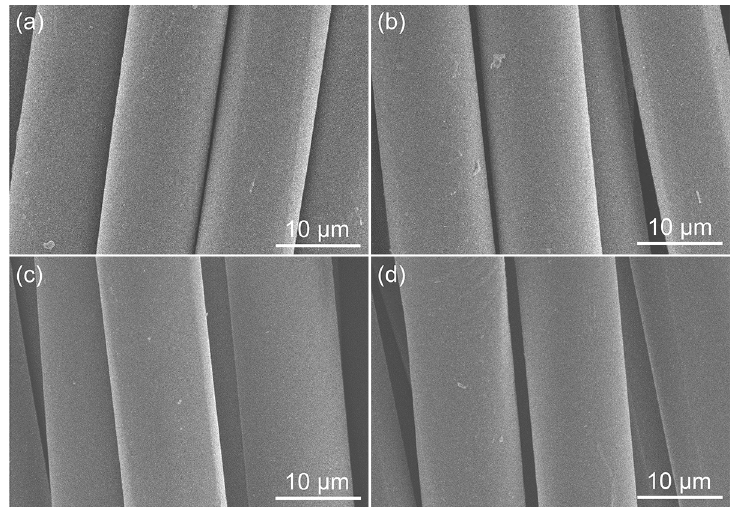
Figure 3. SEM images of PI fibers ( a ) and the PI fibers treated with N-methylformanilide (MFA) ( b ), phenoxyisopropanol (PIP) ( c ), and acetophenone (AP) ( d ).